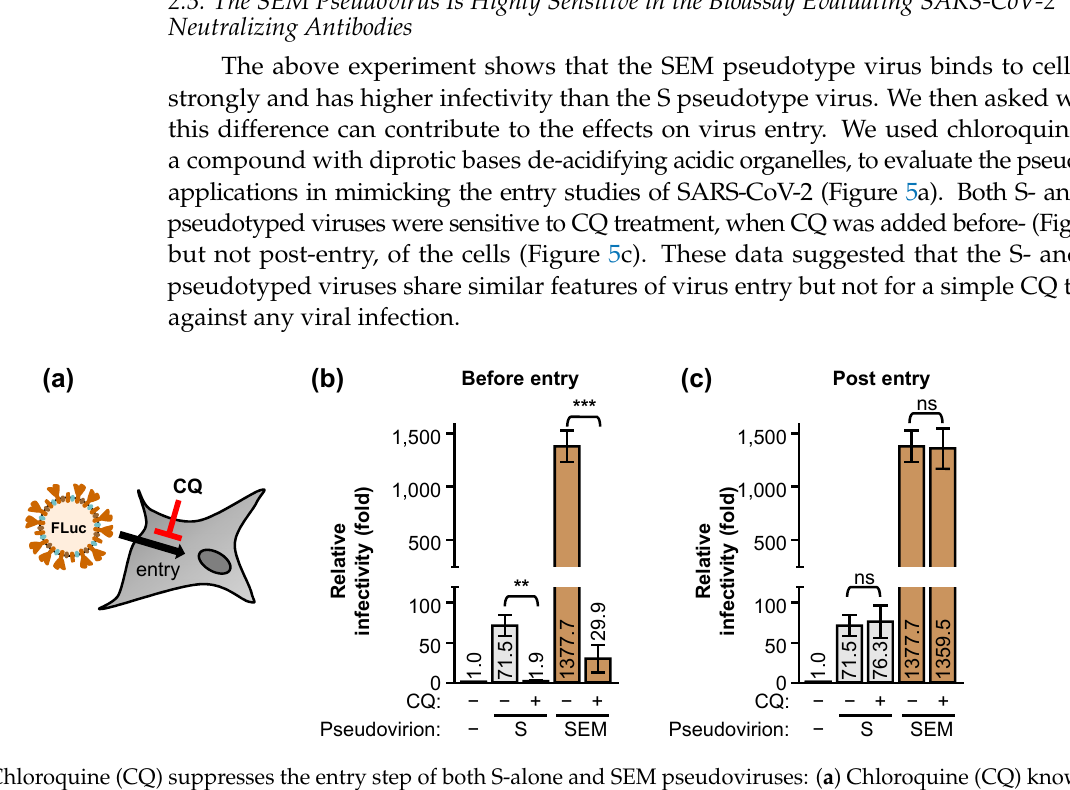
Figure 5. Chloroquine (CQ) suppresses the entry step of both S-alone and SEM pseudoviruses: ( a ) Chloroquine (CQ) known for suppressing virus entry was illustrated. ( b , c ) BHK-hACE2 cells were infected with the S-alone or SEM pseudovirus in the presence (+) or absence ( − ) of CQ (100 µ M) as indicated. The cells were treated with CQ for 30 min before the infection ( b ; before-entry) or after 6 h of the infection ( c ; post-entry). The relative infectivity was estimated by the luciferase activity normalized to the mock group. Data ( b , c ) are mean ± SD, n = 3 per group, and were compared by two-tailed Student’s t test. **, p < 0.01; ***, p < 0.001; ns, no